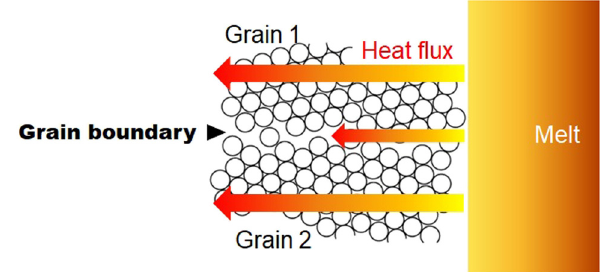
Figure 10: Schematic image of thermal di ff usivity at a crystal/melt interface with a grain boundary [ 97 ] . The thermal conductivity at the grain boundary is lower than that within the grain due to the dis - ordered atomic con fi